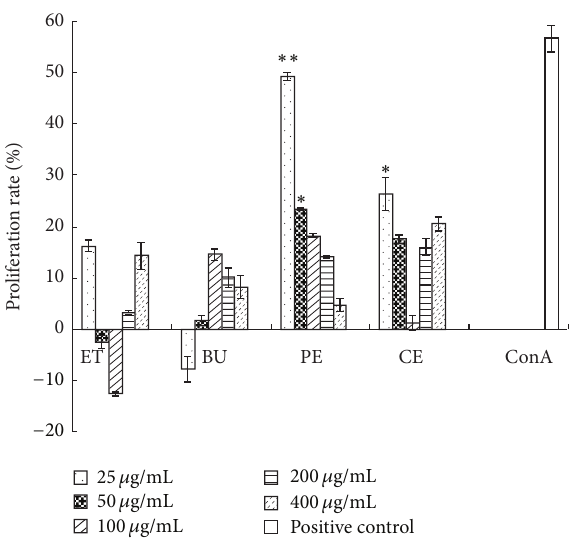
Figure 2: Effects of extracts on the proliferation of the mouse peritoneal macrophages. ∗ 𝑃 < 0.05 and ∗∗ 𝑃 < 0.01 compared with the